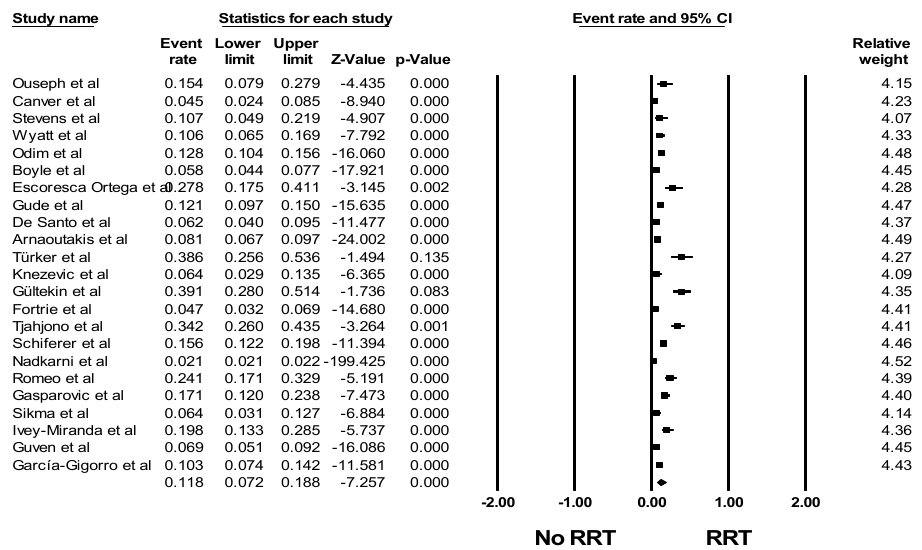
Figure 3. Forest plots of the included studies assessing incidence rates of AKI requiring RRT among patients undergoing cardiac transplantation. A diamond data marker depicts the overall rate from each included study (square data marker) and 95% CI.